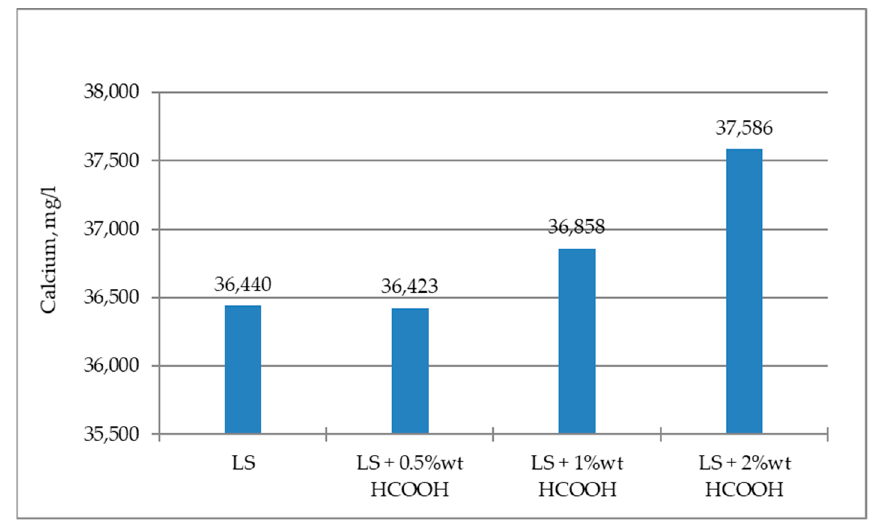
Figure 9. Calcium in the washing bottle after flue gas cleaning. The presence of all scrutinized parameters was detected in the gas washing